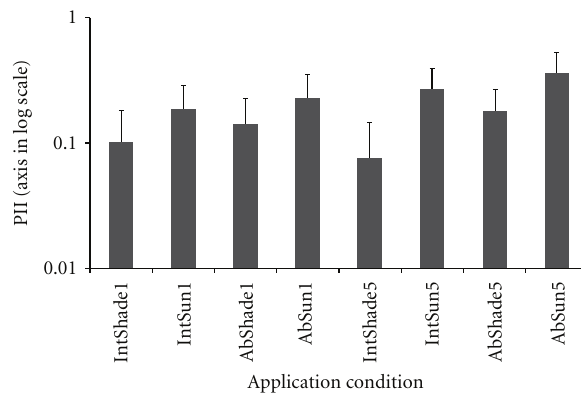
Figure 1: The average PII and standard deviation (error bar) of the cosmetics applied once and five consecutive days on a rabbit skin at di ff erent condition. IntShade1: applied once on intact skin under shade, IntSun1: applied once on intact skin under sun, AbShade1: applied once on abraded skin under shade, AbSun1: applied once on abraded skin under sun, IntShade5: applied five consecutive days on intact skin under shade, IntSun5: applied five consecutive days on intact skin under sun, AbShade5: applied five consecutive days on abraded skin under shade, AbSun5: applied five consecutive days on abraded skin under